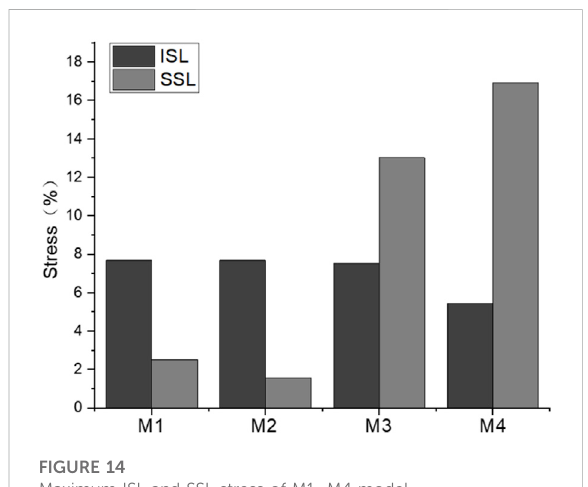
FIGURE 14 Maximum ISL and SSL stress of M1 – M4